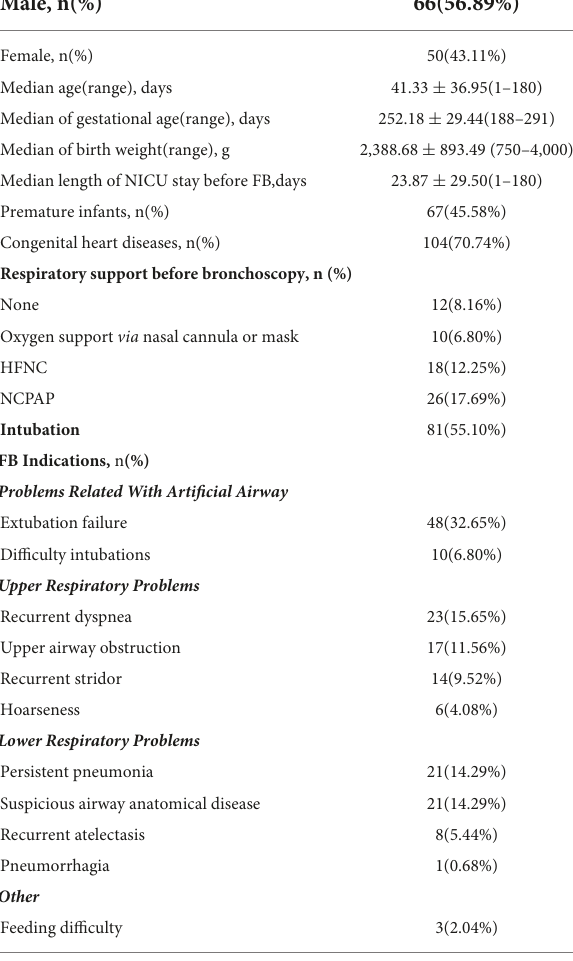
TABLE 1 General characteristics of the patient (n: